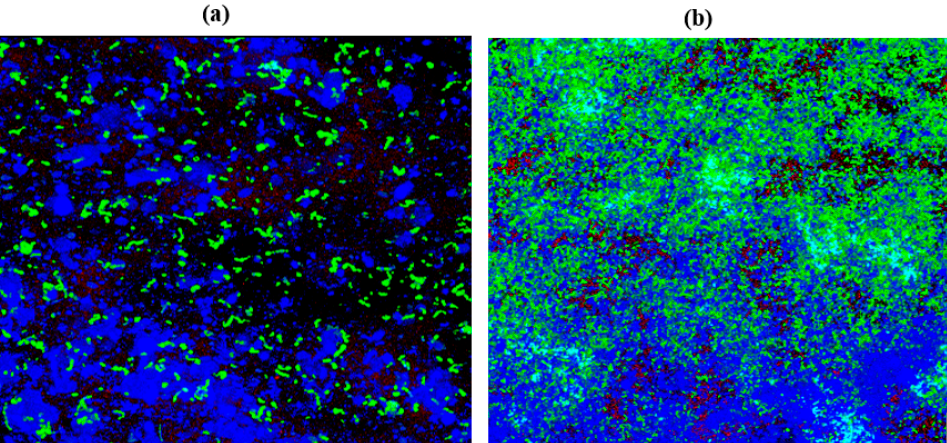
Figure 8. 3D resolution images of E. coli ATCC 39936 control using CLSM at ( a ) 12 h; ( b ) 24 h. All images were captured at 40× magnification under oil immersion.